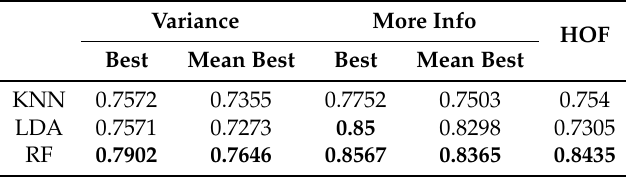
Table 5. Summary results for each